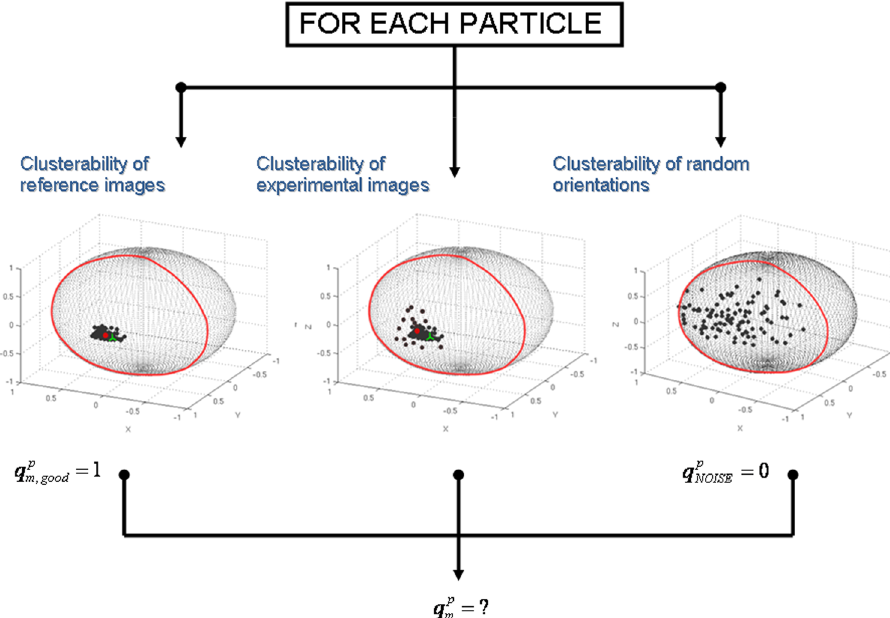
Figure 2. Diagram of the alignment precision and accuracy estimation process for each experimental particle. First, the clusterability of the orientation distribution is obtained for the experimental, perfect and pure noise particles. These values are used to give an alignment precision score to each experimental particle between 0 and 1. In addition, the alignment accuracy is computed comparing the previously obtained particle orientation (green cross) with the weighted average orientation of most similar map projections (red